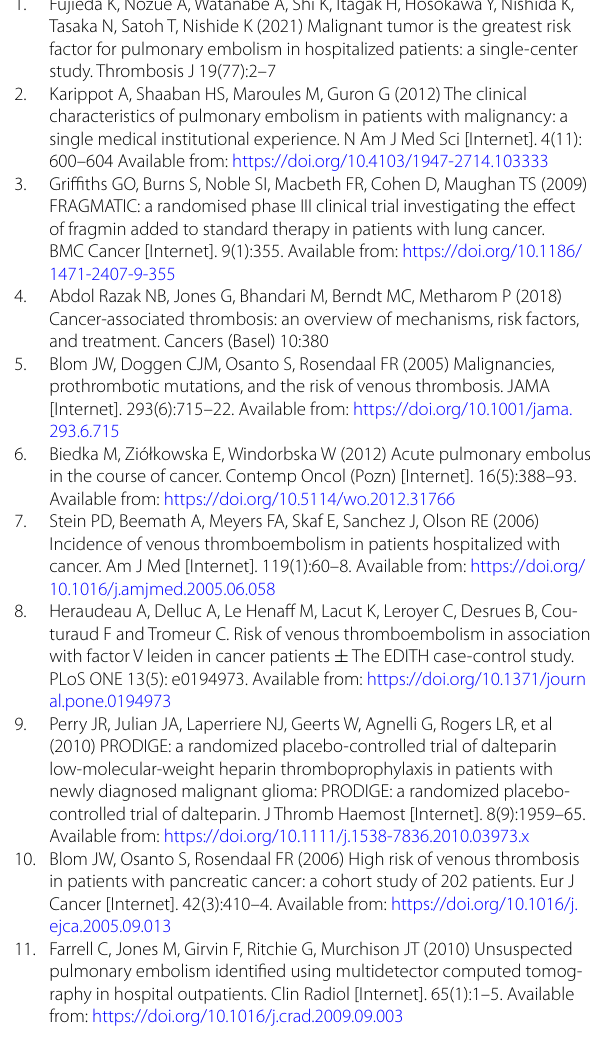
Clinical suspected PE(37)well score > 4